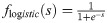
Comparison of the approaches of Case [44,45], Werner and Griebeler [8] and Myhrvold [10] to infer scaling regressions on maximum mass gain and asymptotic body mass for vertebrate taxa.We used the growth model as formulated in Myhrvold [10] (m(t) = Mflogistic(s) + Mc with flogistic(s)=11+e−s and s = k(t − tc)) to establish logistic growth curves for 10 abstract species. Their asymptotic body masses (M) were 100, 200, 300, 400, 500, 600, 700, 800, 900, and 1000 mass units. The constant mass offset parameter Mc and the age offset parameter tc in this model were set to 0. The growth parameter k with the dimension of inverse time was set to 0.5 for all species. Under this setting the maximum growth rate Gmax of a species (= MkC, mass units per time unit) is M*0.5*0.25, as the dimensionless factor C is 0.25 for the logistic growth model. (A) Growth curves of species, m(t) evaluated for ages (t) 0 up to 40. (B) M is independent of kC. (C) Maximum mass gain versus body mass obtained under Myhrvold’s [10] kC-approach, no relation between M and kC. (D) Relationship when plotting Gmax against BMatMG (body mass at which Gmax is observed, Werner and Griebeler [8], 50% of M under a logistic growth model, solid line) or against M (dotted line, adult mass, approach of Case [44]), this is a unique relation between Gmax and BMatMG (M), and it is consistent with the empirical observations that Gmax values are higher in larger than in smaller species. Please note that for simplicity axes in (C) and (D) are not log-transformed.